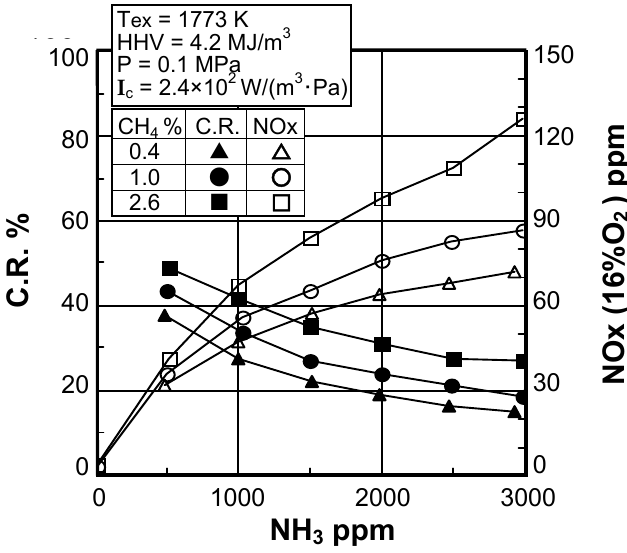
Figure 57. Influence of NH concentration as a